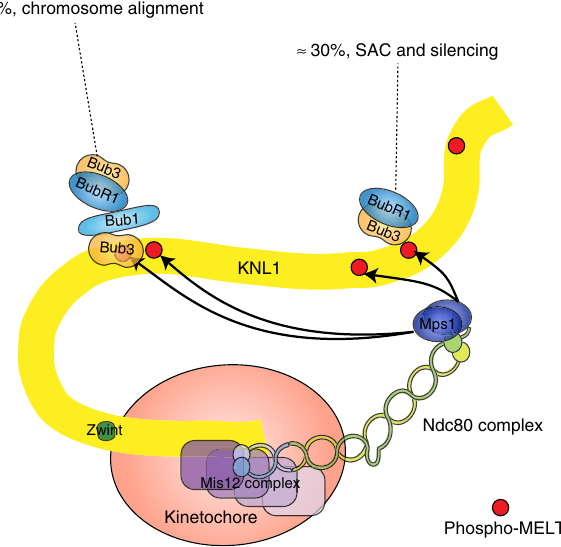
Figure 7 | Model for the regulation of chromosome segregation by BubR1. The major population of BubR1/Bub3 depends on Bub1/Bub3 for localization and is required for alignment of chromosomes. The minor pool of BubR1/Bub3 interacts directly with phosphorylated MELTmotifs on KNL1 and is required for SAC signalling and silencing. Bub3 bound to BubR1 is required for the localization of both